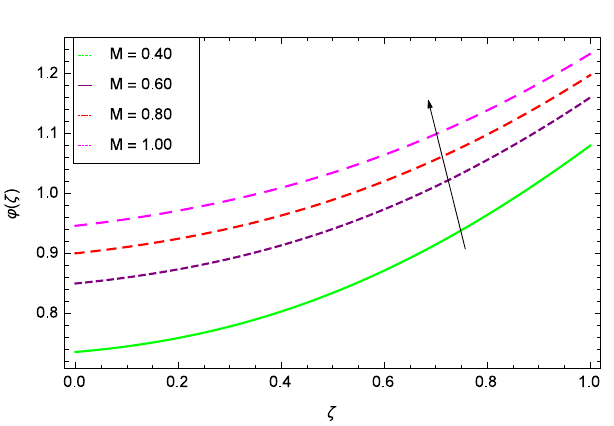
Figure 30. Parameter effect on concentration of homogeneous chemical reactions ϕ ( ζ )